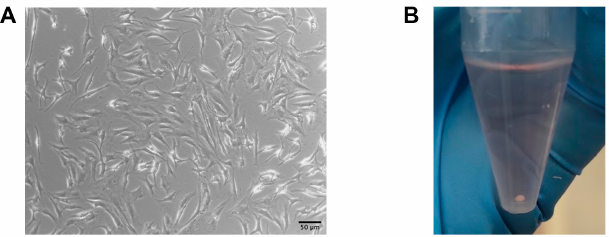
Figure 2. Two ‐ dimensional and three ‐ dimensional culture of HACs. A representative phase contrast Figure 2. Two-dimensional and three-dimensional culture of HACs. A representative phase contrast picture of HACs cultivated in chondrogenic medium. Scale bar: 50 μ m ( A ). An illustrative photo of picture of HACs cultivated in chondrogenic medium. Scale bar: 50 µ m ( A ). An illustrative photo of a a HAC 3D pellet cultured in a polystyrene 15 mL tube ( B ). HAC 3D pellet cultured in a polystyrene 15 mL tube ( B